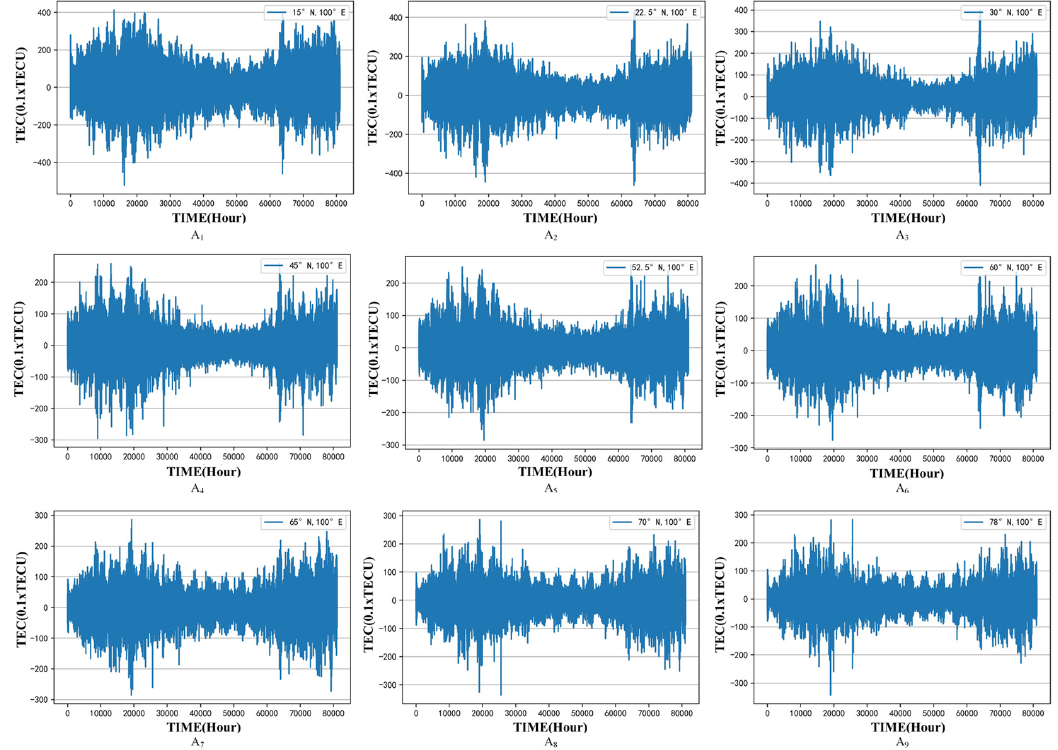
Figure 2. The first-order difference of TEC data in 9 regions selected in this paper.